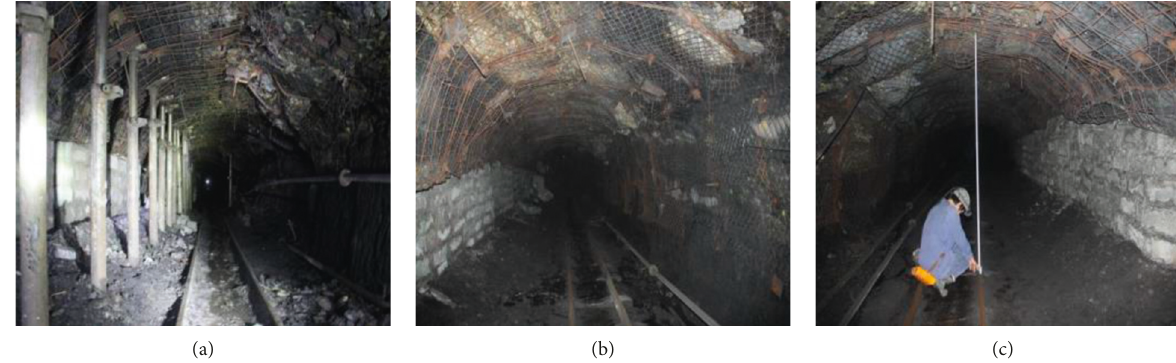
Figure 31: The effect of gob-side entry retaining: (a) 30m from working face, (b) 100m from working face, and (c) 180m from working